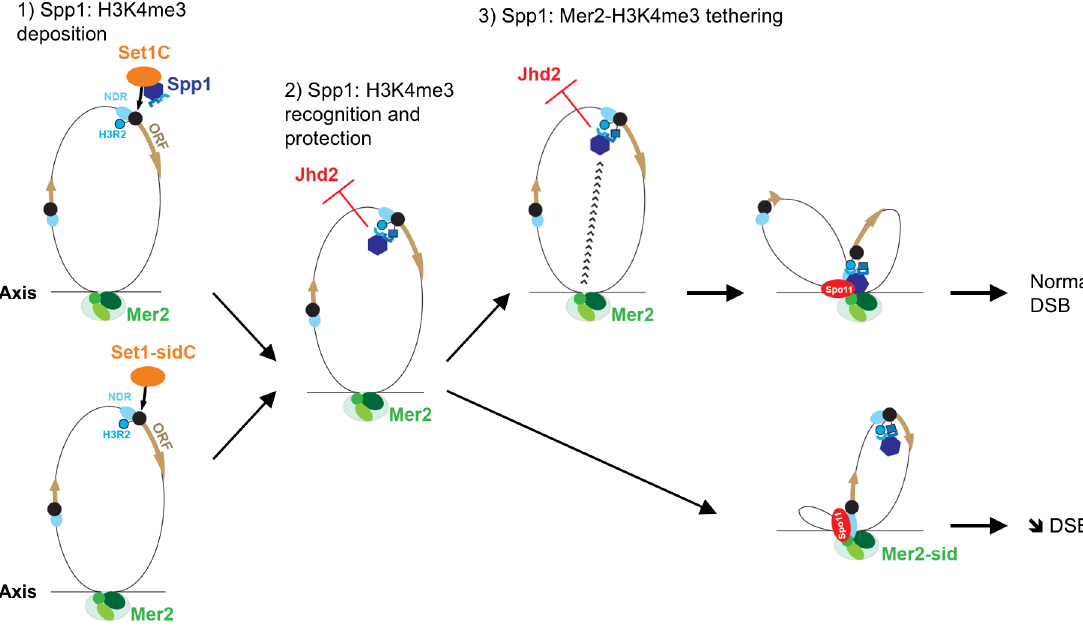
Fig 7. Illustration of the different functions of Spp1 for H3K4me3 and meiotic DSB formation. 1) in the Set1 complex, Spp1 has a role to allow catalysis of H3K4 trimethylation by Set1, but this function is not essential, since the set1-sid mutant still maintains high levels of H3K4me3. 2) In addition, Spp1 maintains H3K4me3 levels, not by stimulating Set1 catalytic activity, but likely by binding H3K4me3 with its PHD finger. This can take place without interaction with the Set1 complex. We propose this may protect H3K4me3 from active demethylation, by the Jhd2 enzyme. Other possible explanations are described in the text. 3) Finally, the simultaneous binding of Spp1 to H3K4me3 and to the axis-associated Mer2 protein is essential to promote efficient DSB formation by Spo11. It has to be noted that a PHD finger mutant of Spp1 (W45A) is still able to bind Mer2 [18], so recognition of H3K4me3 by Spp1 PHD finger is not a prerequisite for its subsequent binding to Mer2. NDR: nucleosome-depleted region; Black circle: first nucleosome of genes; H3R2: arginine 2 of histone H3, in its non-asymmetrically methylated form. The blue square represents